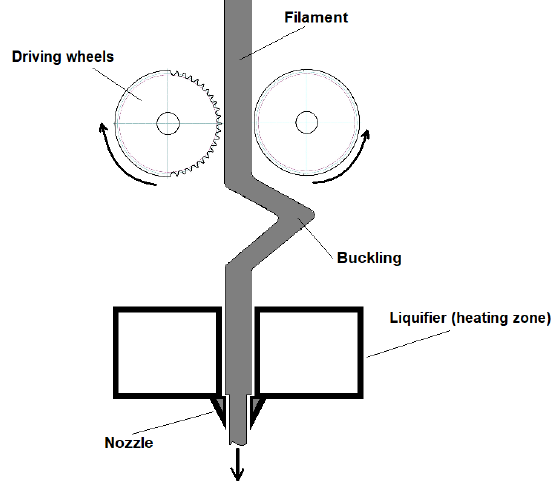
Figure 8. Illustration of filament buckling due to exceeding a printing speed of 3 mm/s.